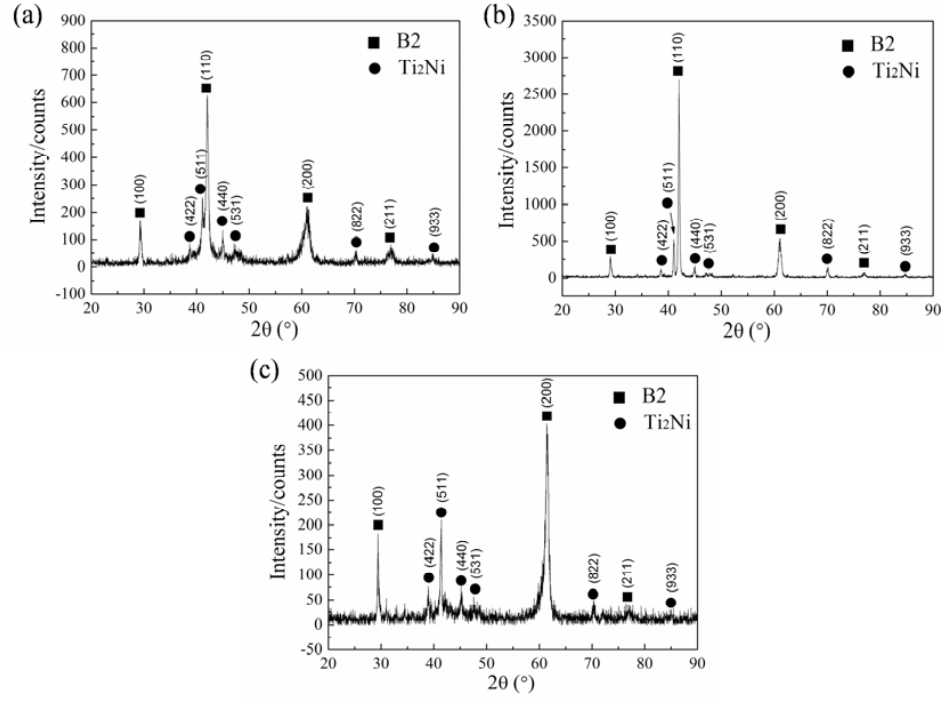
Figure 2. XRD (X-ray diffraction) maps of the three NiTi-based SMAs: ( a ) Ni 45 Ti 51.8 Fe 3.2 ; ( b ) Ni 44 Ti 51.8 Fe 3.2 Nb 1 ; ( c ) Ni 44 Ti 51.8 Fe 3.2 Ta 1 .